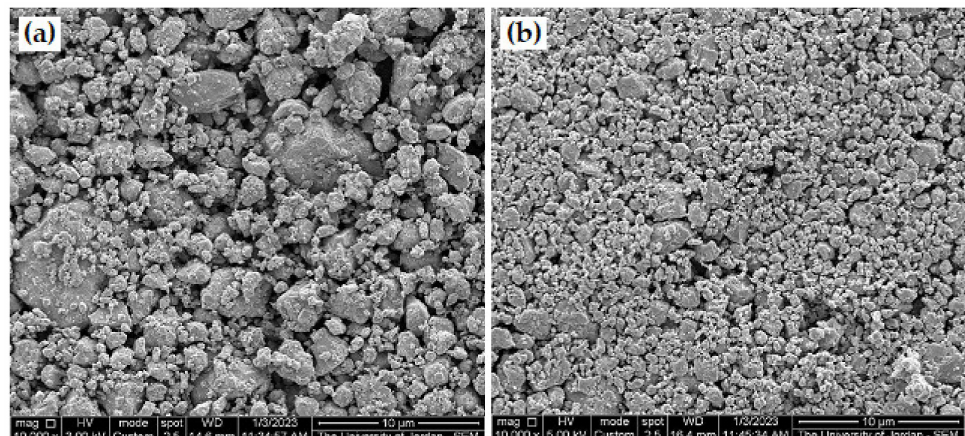
Figure 8. SEM micrographs (SEI) at same magnification 10,000 × ( a ) general image, as milled galena powder after 15 milling time, ( b ) image of water separated galena powder from the produced powder of 15 min milling time.